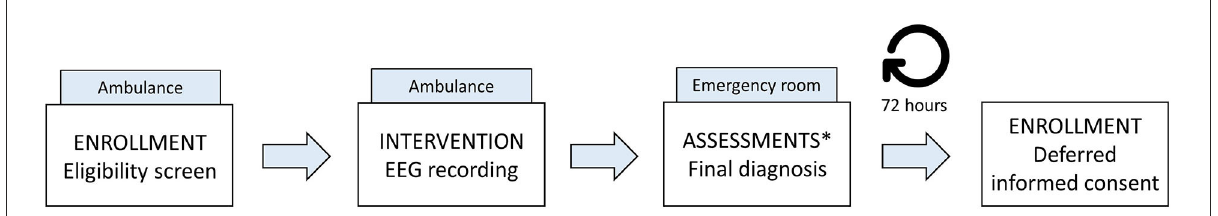
FIGURE3 Flowchart of enrollment, intervention, and assessments in the study. There is no follow-up. *Assessments include patient characteristics, such as demographics, medical history, medication use, and data obtained at the emergency room as part of the work-up for the suspected acute ischemic stroke, such as the neurological examination, radiological data, final diagnosis, and treatment.